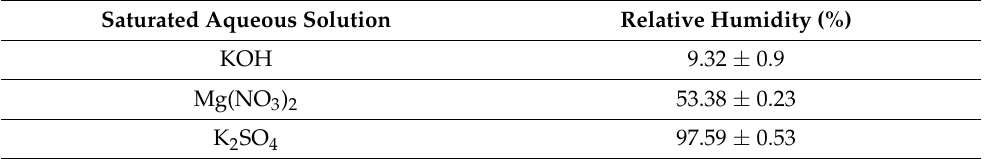
Table 2. Equilibrium RH over a saturated aqueous solutions of selected salts at 20 ◦ C